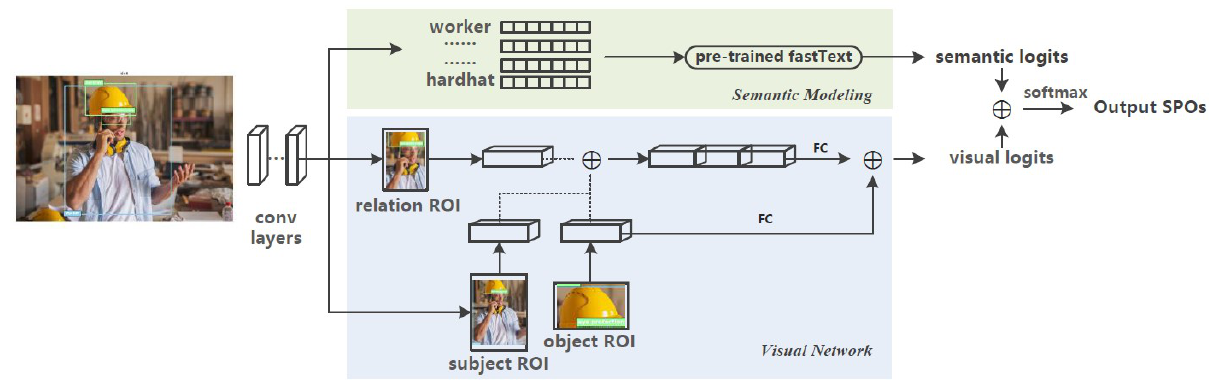
Figure 4. The on-site scene parsing module